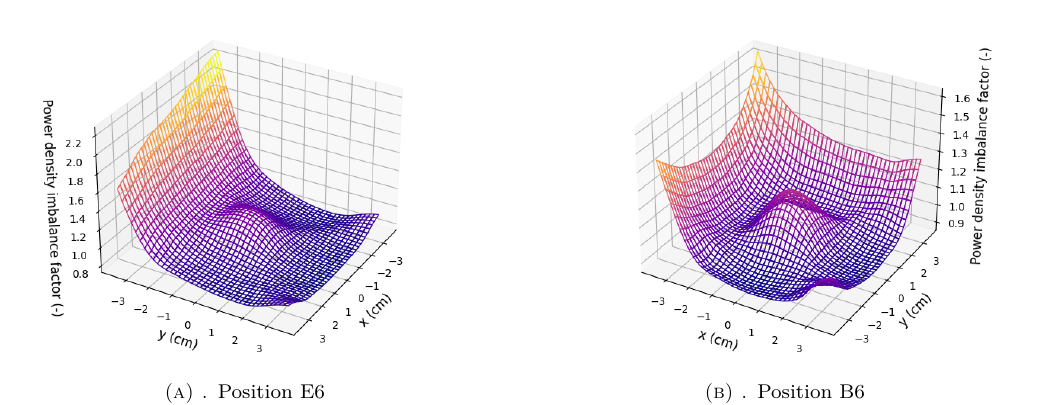
Figure 4. RBF interpolation of reference data.